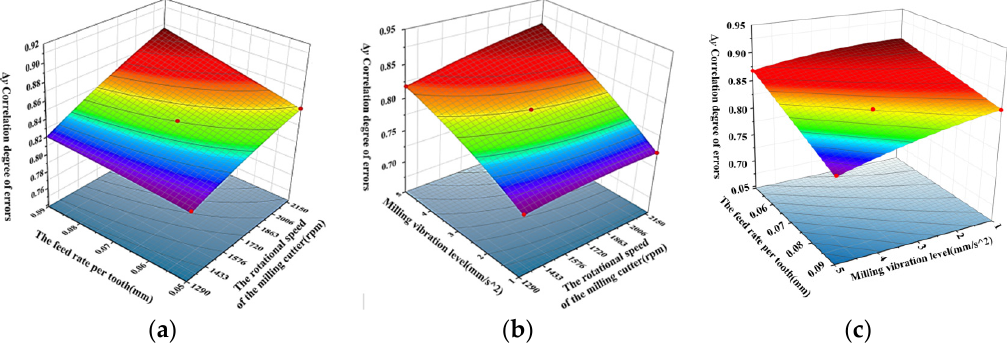
Figure 9. Response surface of design variable interactions with positional error: ( a ) The feed rate per tooth and rotational speed of the milling cutter. ( b ) The rotational speed of the milling cutter and milling vibration level. ( c ) The feed rate per tooth and milling vibration